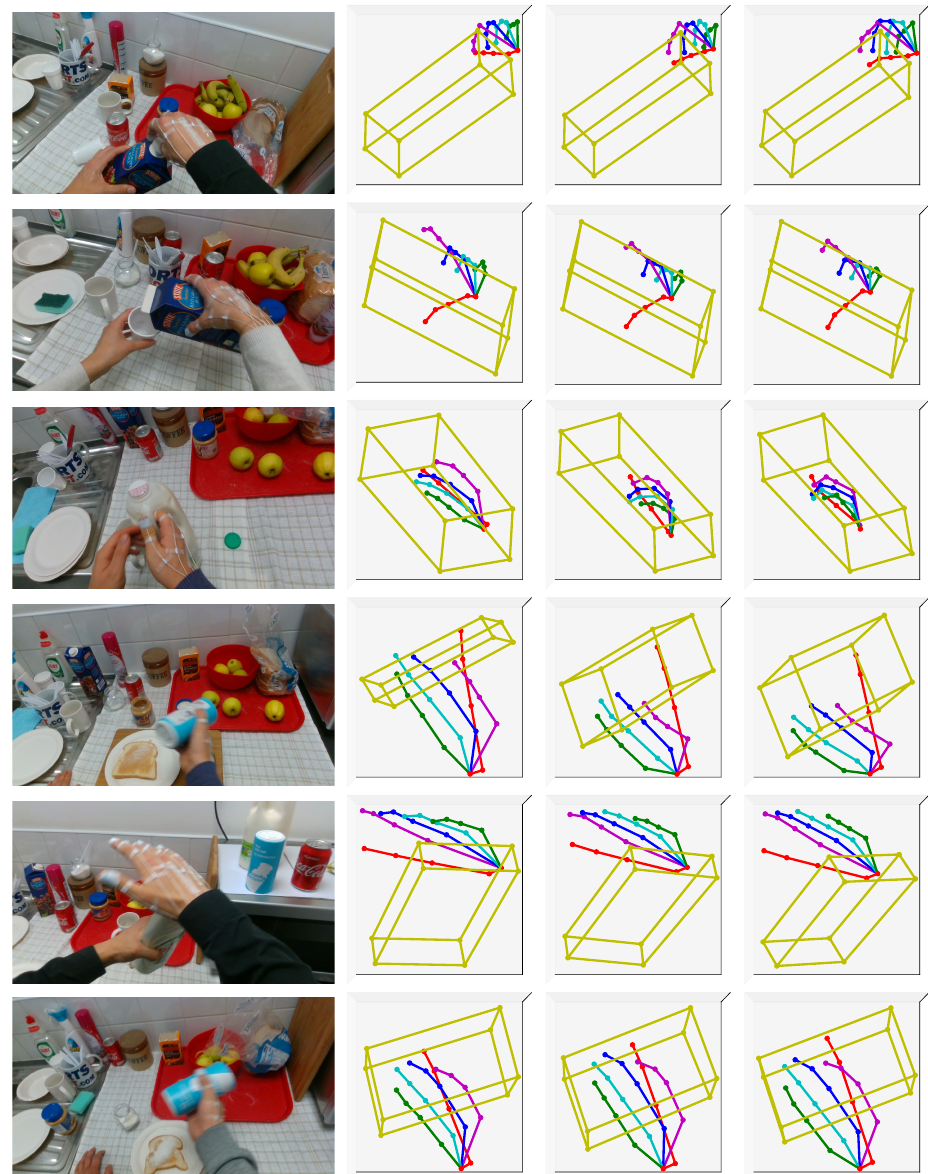
Figure 6. Qualitative results of our method on the FPHA-HO dataset. From left to right: input image, coarse pose results without using InterGCN, refined pose results, and ground truth. The proposed coarse-to-fine framework can handle diverse HOI scenarios with different objects and severe occlusions.